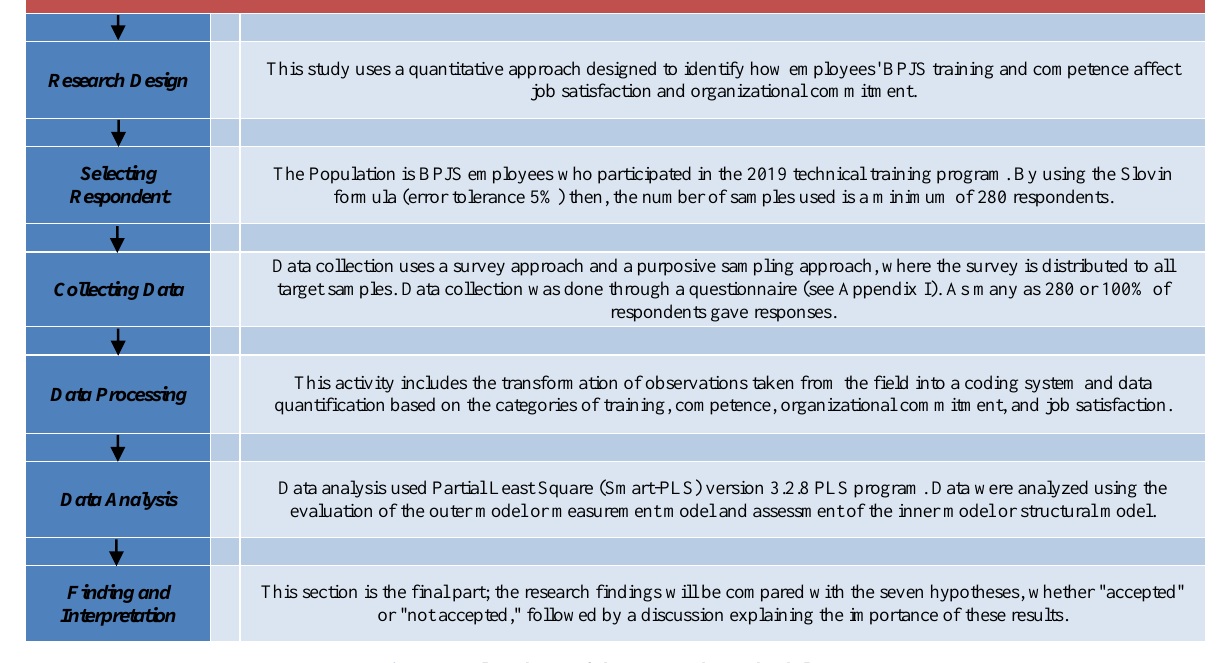
Figure 1. Flowchart of the research